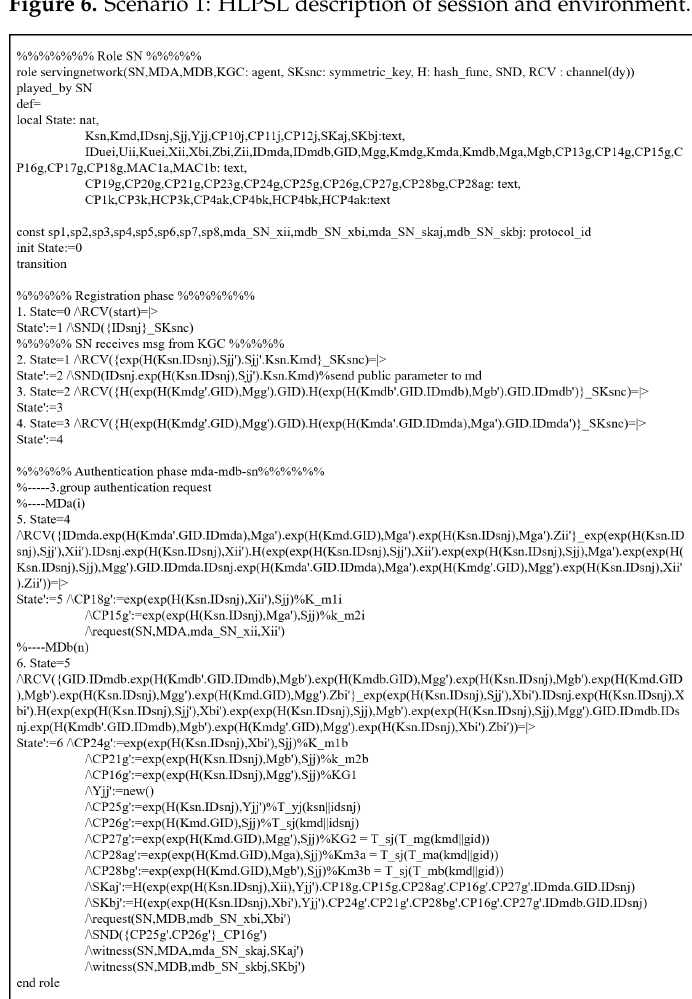
Figure 7. Scenario 2: HLPSL description of SN